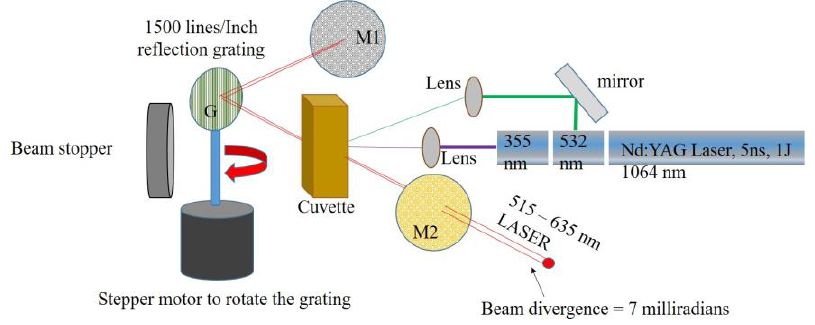
Figure 7. The laser set-up.